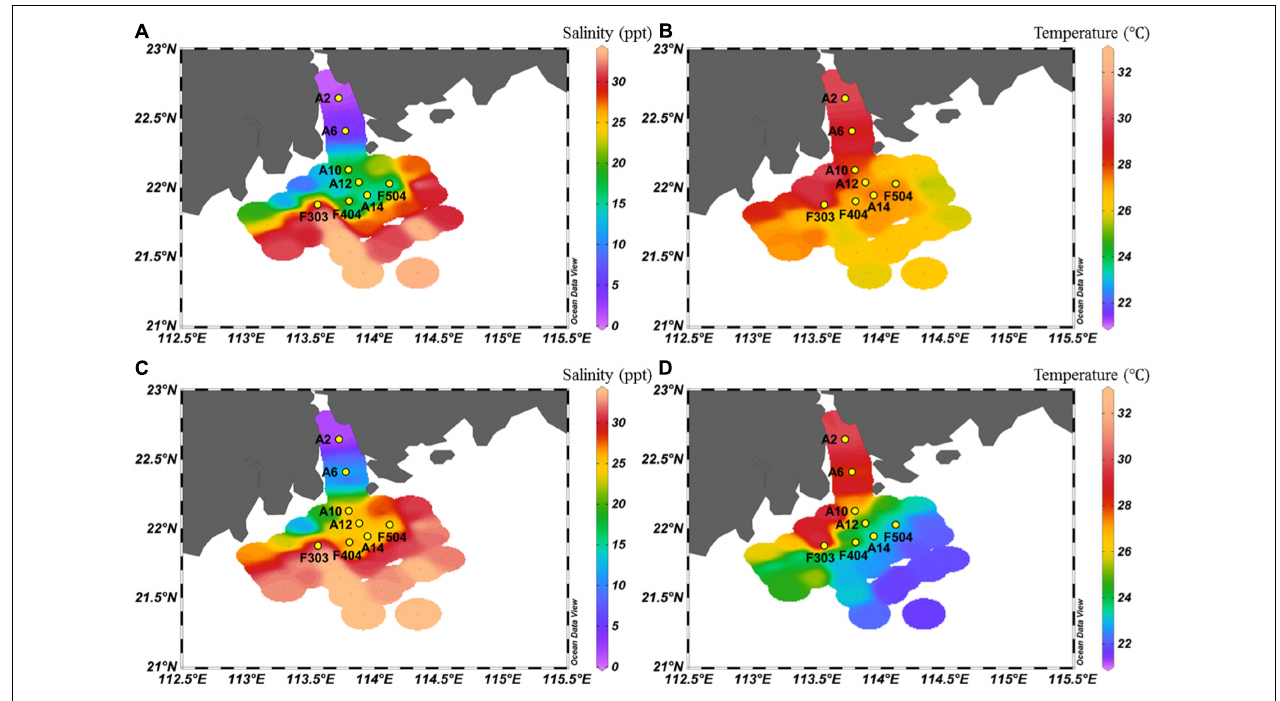
FIGURE 1 | Salinity (A,C) and temperature (B,D) of surface (A,B) and bottom (C,D) water of the study area. TABLE 1 | Characteristics of sampling sites and measured environmental